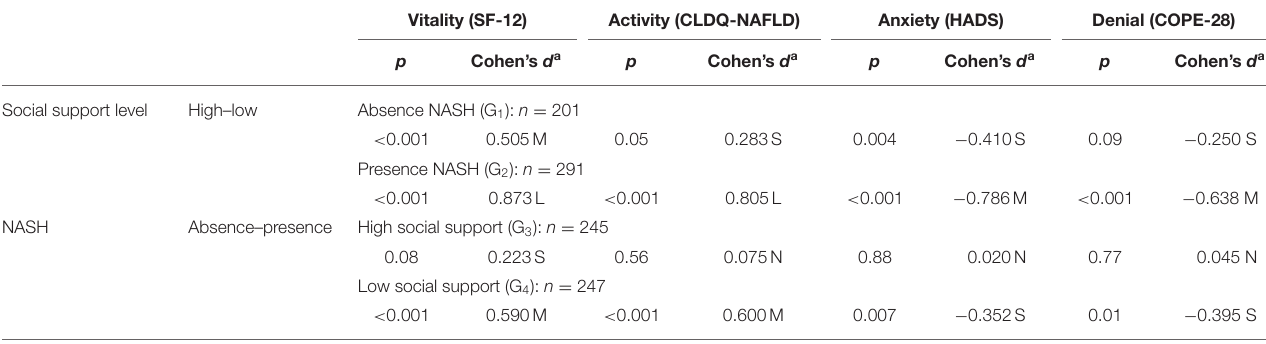
TABLE 5 | Simple effects in vitality (SF-12), activity (CLDQ-NAFLD), anxiety (HADS), and denial (COPE-28).